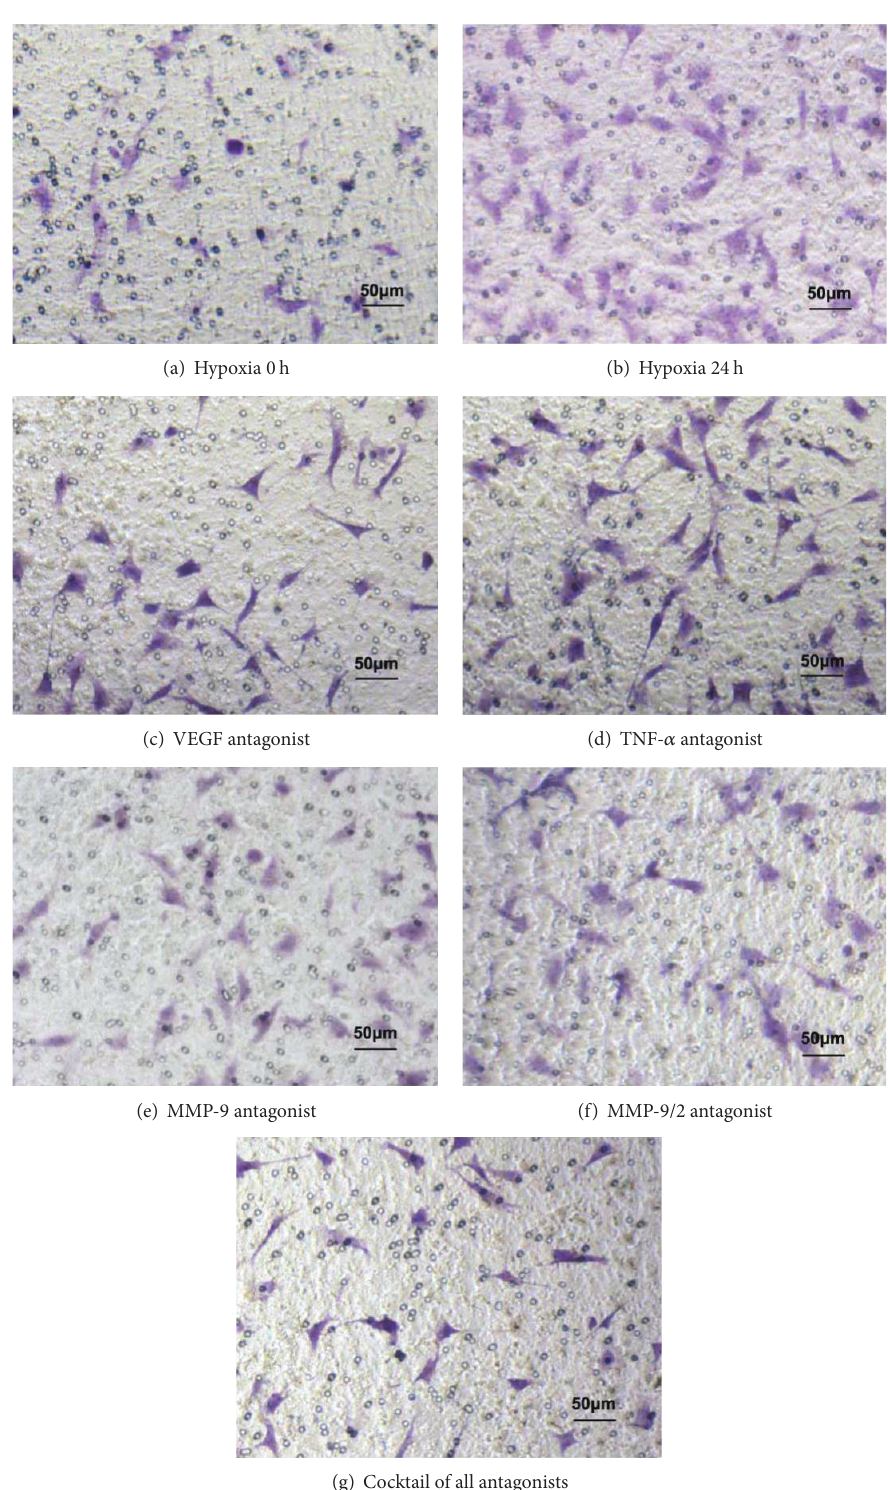
Figure 6: CSCs migration assay with cytokine antagonists. (a) shows CSCs migration induced by supernatant of CFs culture just before being incubated under hypoxia (0h group). Then, CSCs migration induced by supernatant of CFs culture incubating under hypoxia for 24 h was shown in (b). Antagonists for VEGF (c), TNF- 𝛼 (d), MMP-9 (e), MMP-2 (f), and cocktail of all four factors (g) were added to the cells that were induced by CFs culture under hypoxia for 24 h. When all the antagonists were added, the CSCs migration number declined to a minimum